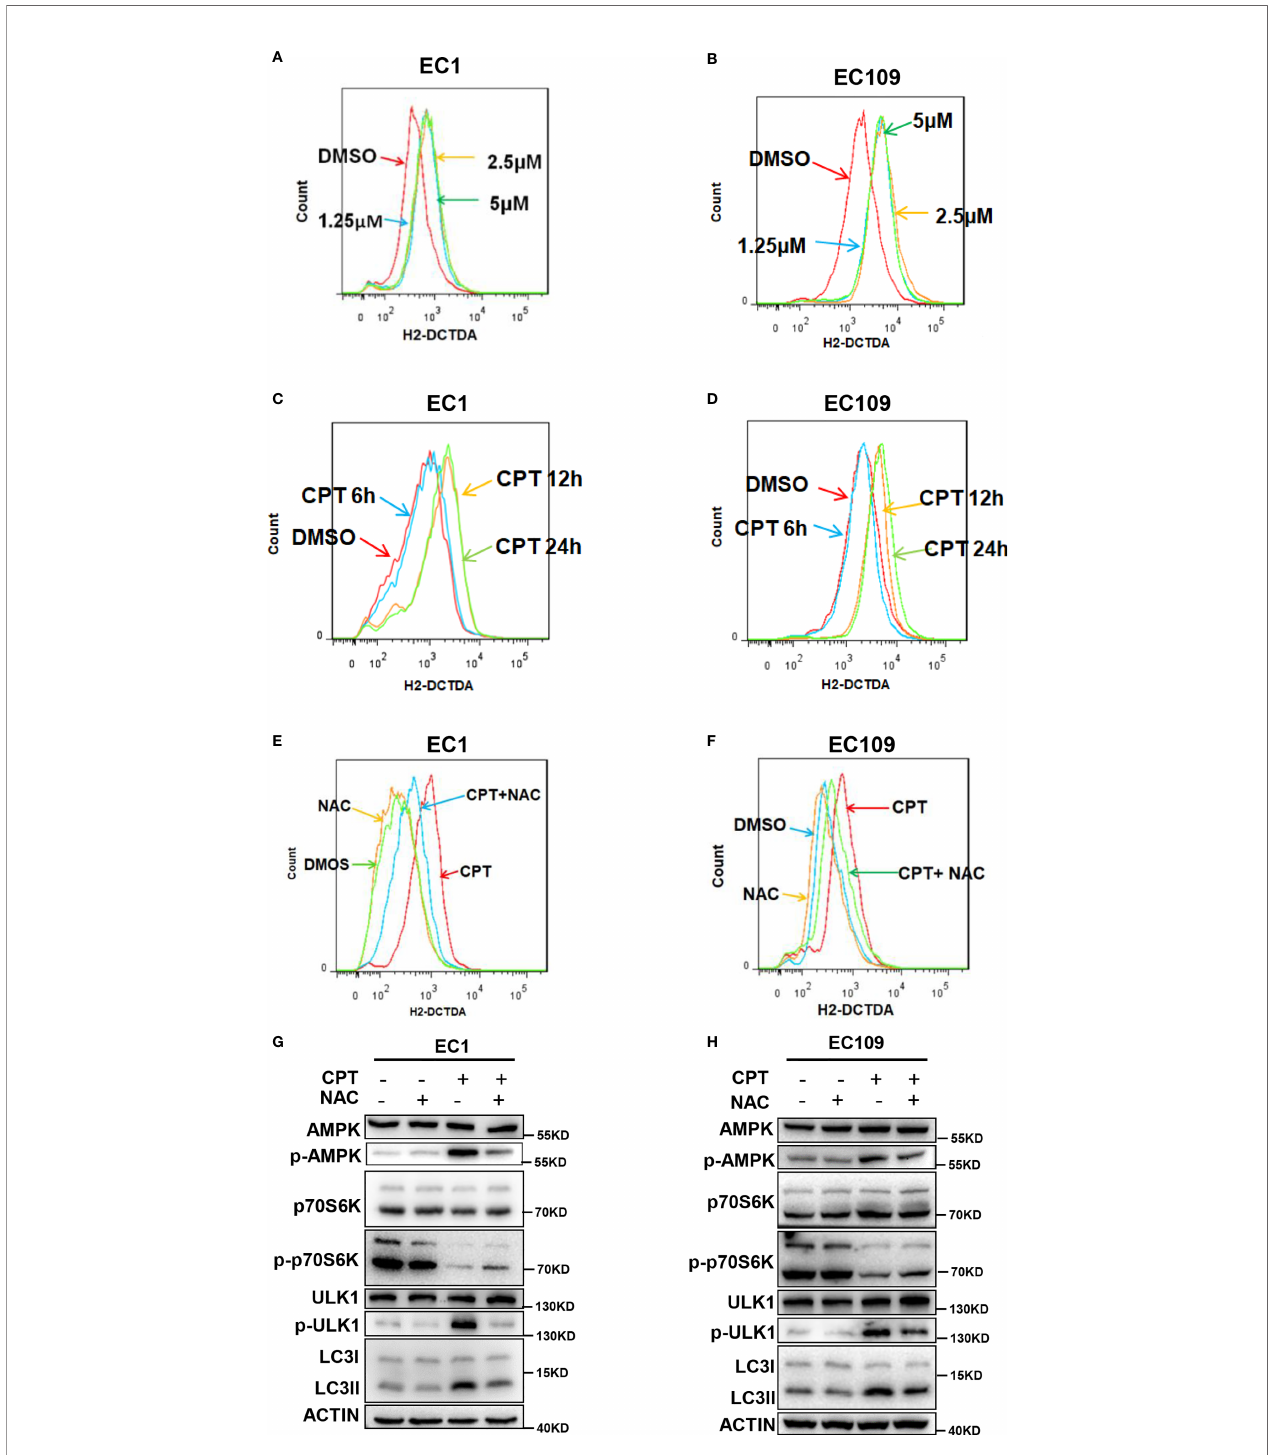
FIGURE 4 | CPT induced ROS generation to promote autophagy via AMPK/mTOR/ULK1 axis. (A – D) CPT elevated ROS levels in ESCC cells. (A, B) Cells were treated with various concentrations of CPT for 24 h. (C, D) Cells were treated with 1.25 m mol/L CPT for the indicated time periods. ROS generation was determined by H2-DCFDA staining and fl ow cytometry. (E, F) EC1 and EC109 cells were treated with 1.25 m mol/L CPT alone or CPT + NAC (50 m mol/L) for 12 h and subjected to H2-DCFDA staining analysis for the levels of ROS. (G, H) NAC inhibited CPT-induced autophagy and suppressed CPT-modulated AMPK/mTOR/ULK1 axis in ESCC cells. EC1 and EC109 cells were treated with 1.25 m mol/L CPT alone or CPT + NAC (50 m mol/L) for 12 h and subjected to IB analysis for the expression of AMPK, p-AMPK, ULK1, p-ULK1, p70S6K, p-p70S6K, and